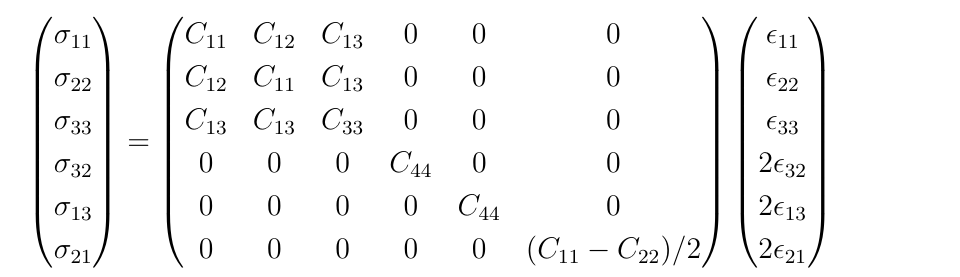
graphite. The more recent data set [20] was deduced from the dispersion curves of acoustic phonons of single-crystalline graphite measured by inelastic X-ray scattering